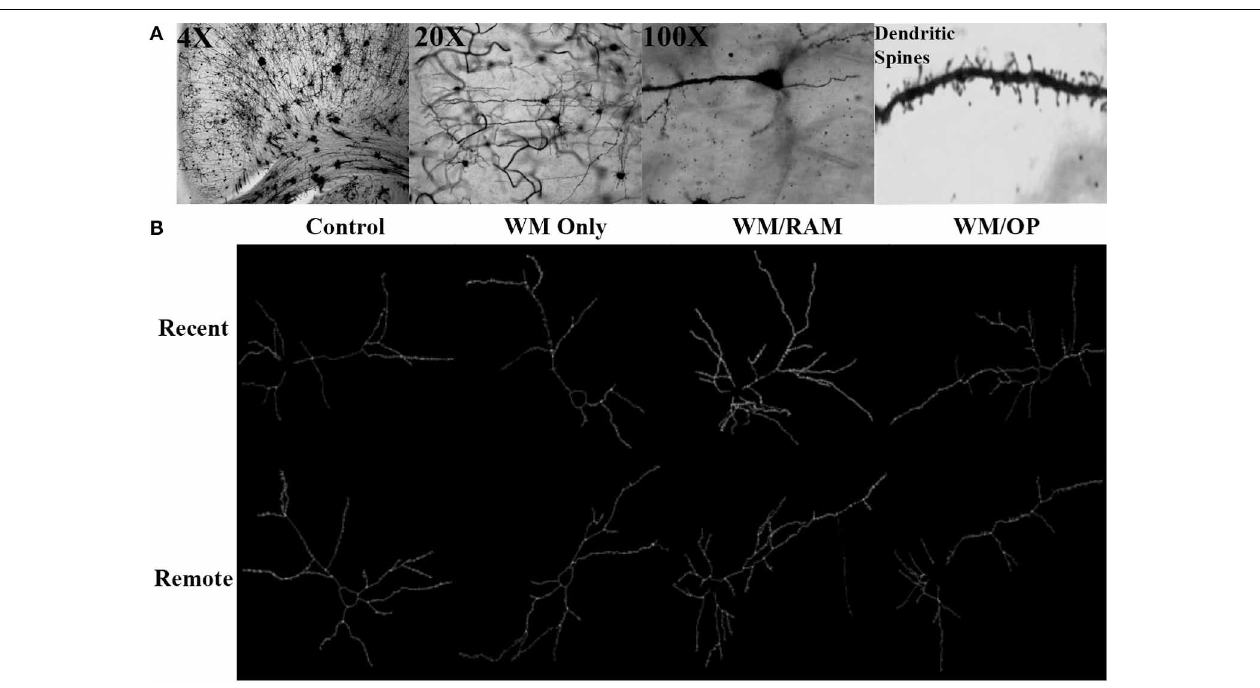
FIGURE 3 | (A) Images of 4X, 20X, and 100X magnified Golgi impregnated neurons in the ACC. A zoomed-in image of an apical dendrite with dendritic spines is shown in the last panel. (B) Representative graphics of Golgi impregnated neurons in the ACC, traced using Neurolucida